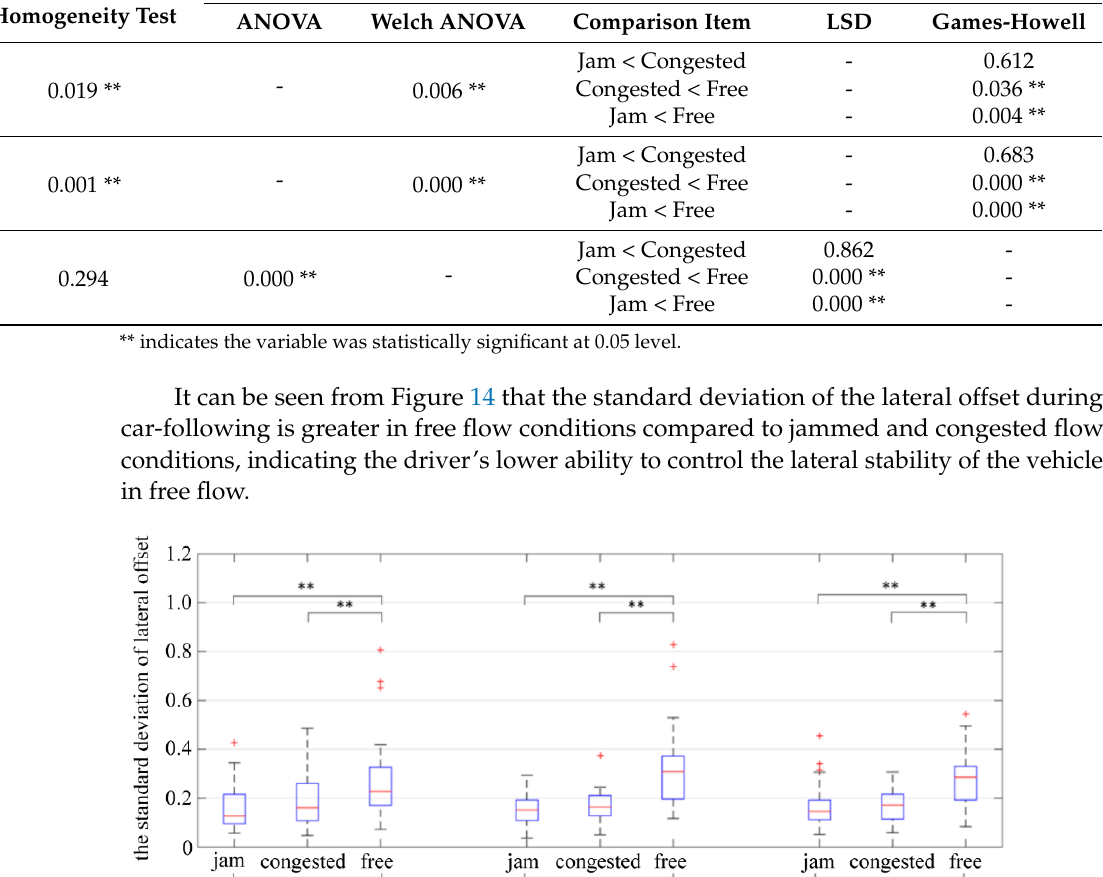
Table 12. Significance test of the effect of traffic flow on the maximum lateral offset.